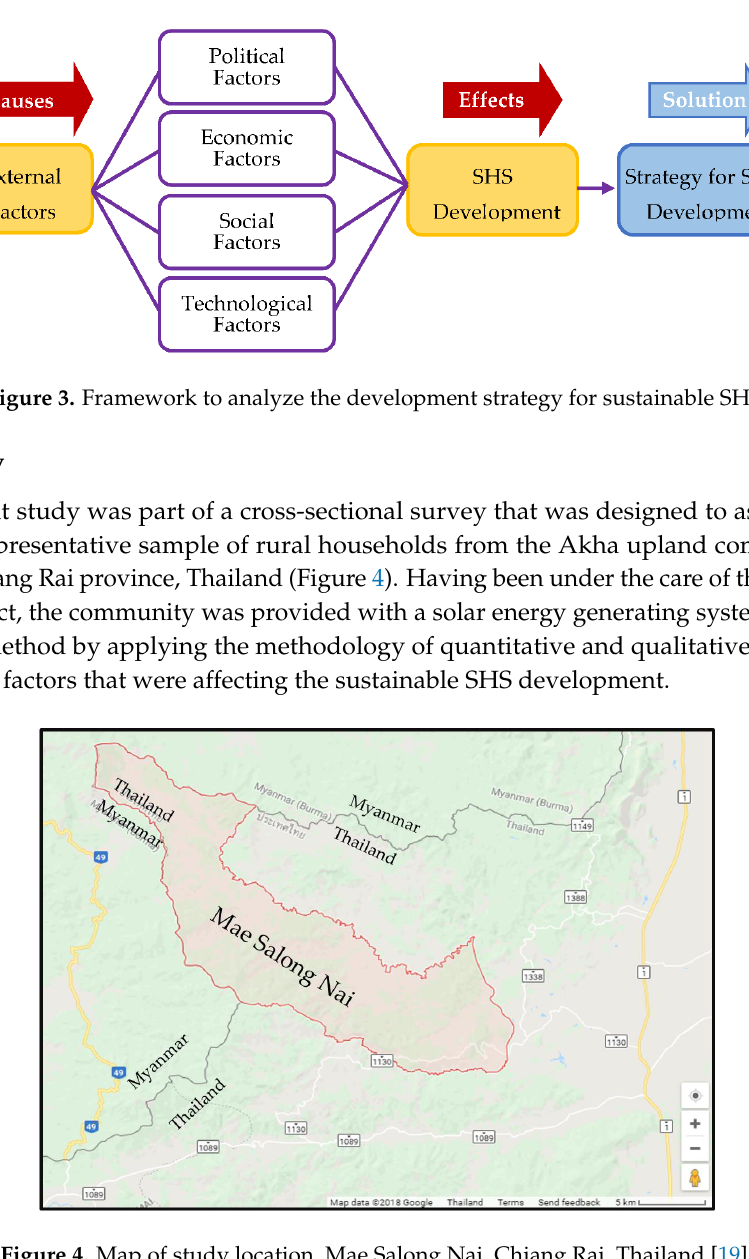
Figure 2. The paradigms of P-E-S-T (political, economic, social-cultural, and technology), based on the solar home system (SHS) project. Source: produced by the authors (2017).